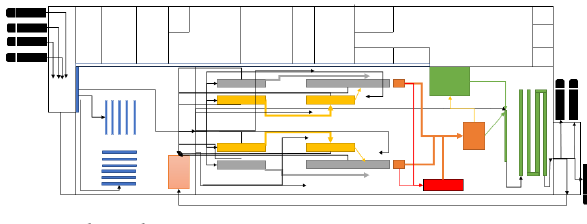
Figure 2: The flows of material in the production of seats